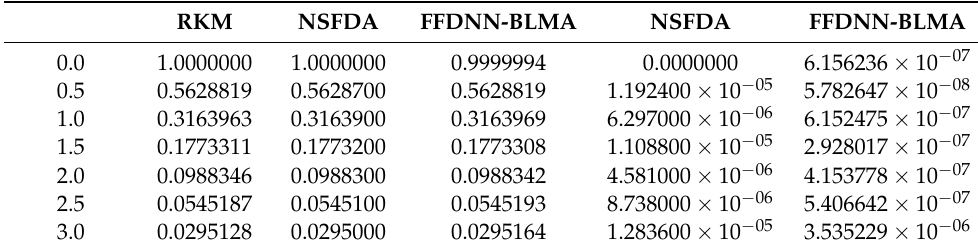
Table 3. Depiction and statistical evaluation of the proposed solutions with recent techniques and overview of the absolute errors of the acceleration with isothermal boundary conditions.